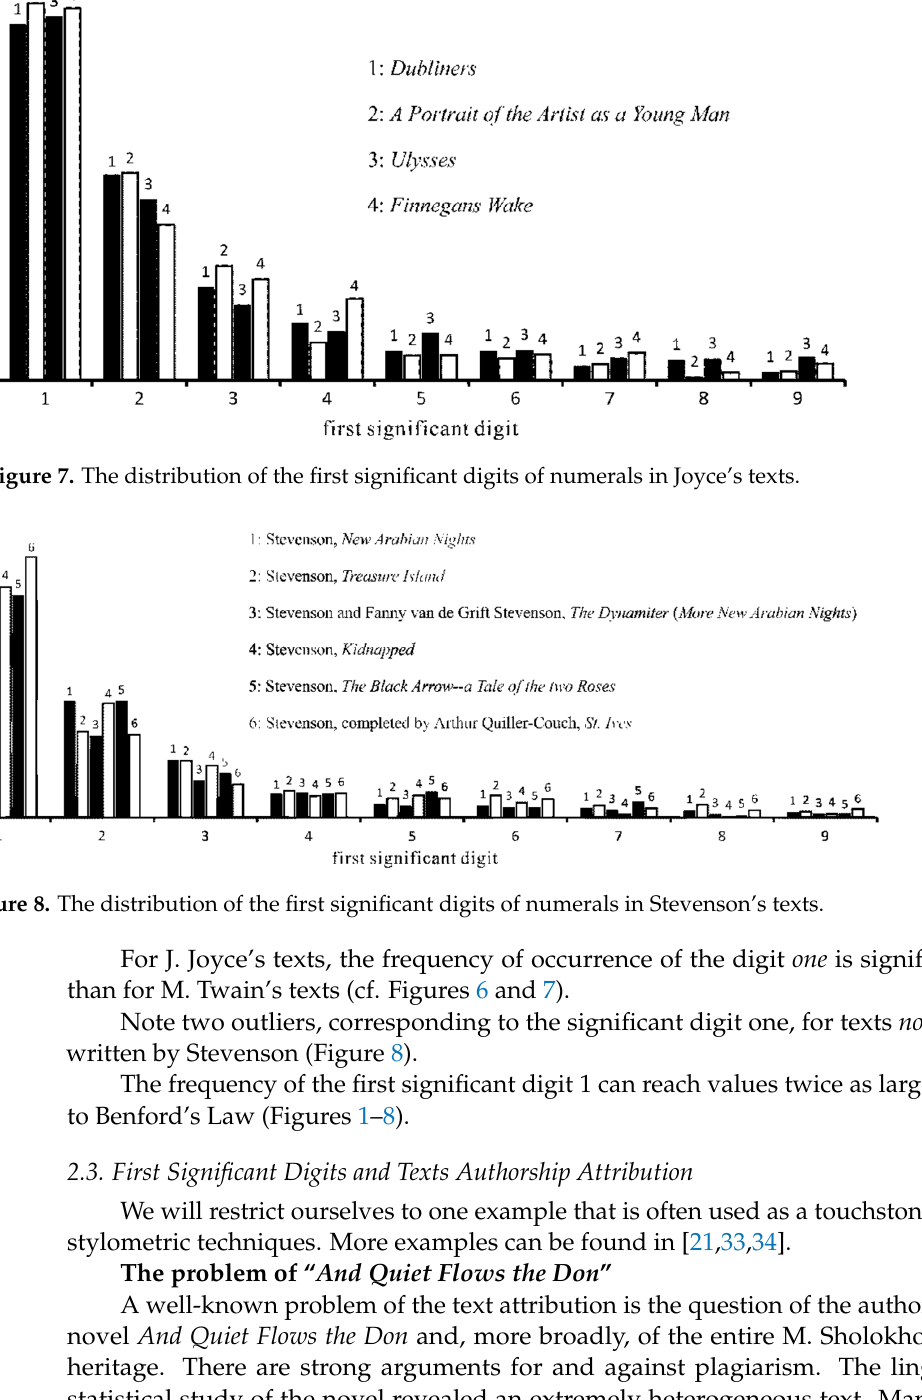
Figure 6. The distribution of the first significant digits of numerals in M. Twain’s texts. For J. Joyce’s texts, the frequency of occurrence of the digit one is significantly less than for M. Twain’s texts (cf. Figures 6 and 7).